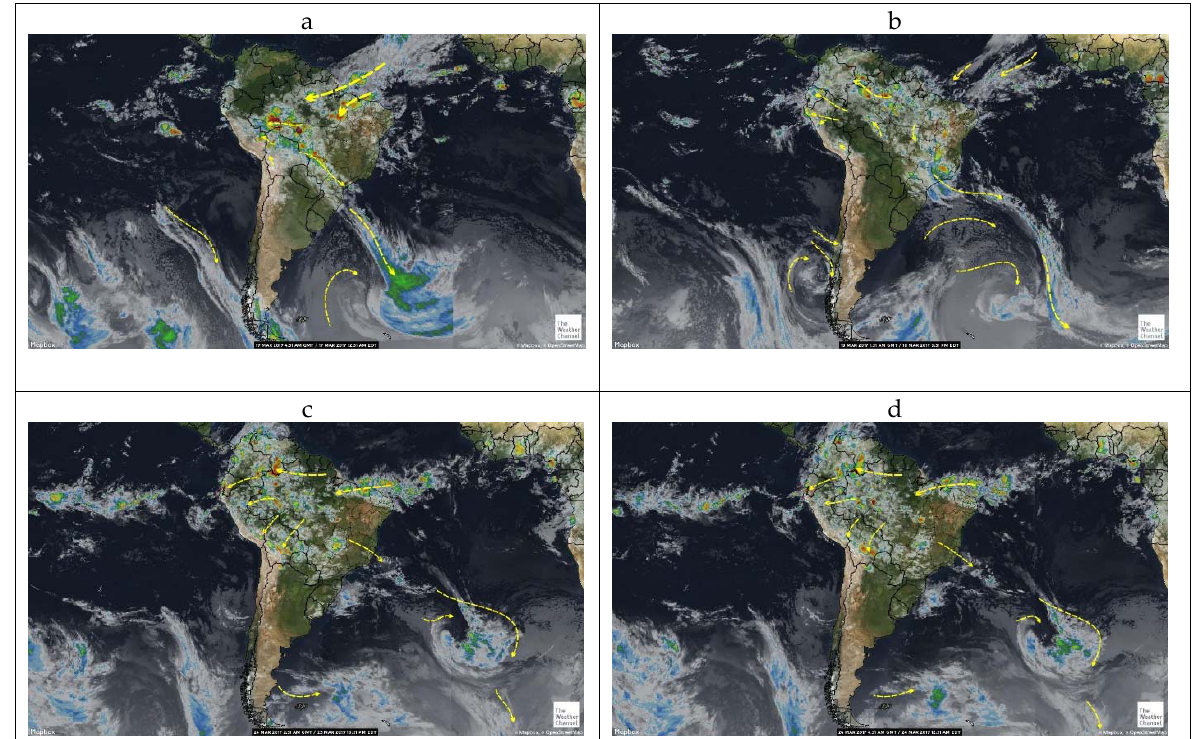
Figure 13. Map of the Inter-Tropical Convergence Zone (ITCZ) bands of heavy rainfall and their displacement in the upper part of South America, and their implications for the Peruvian territory, during the month of March; ( a ) March 17, ( b ) March 18, ( c ) March 23, and ( d ) March 24 Reprinted with permission from ref. [34]. Copyright 2017 The Weather Channel.